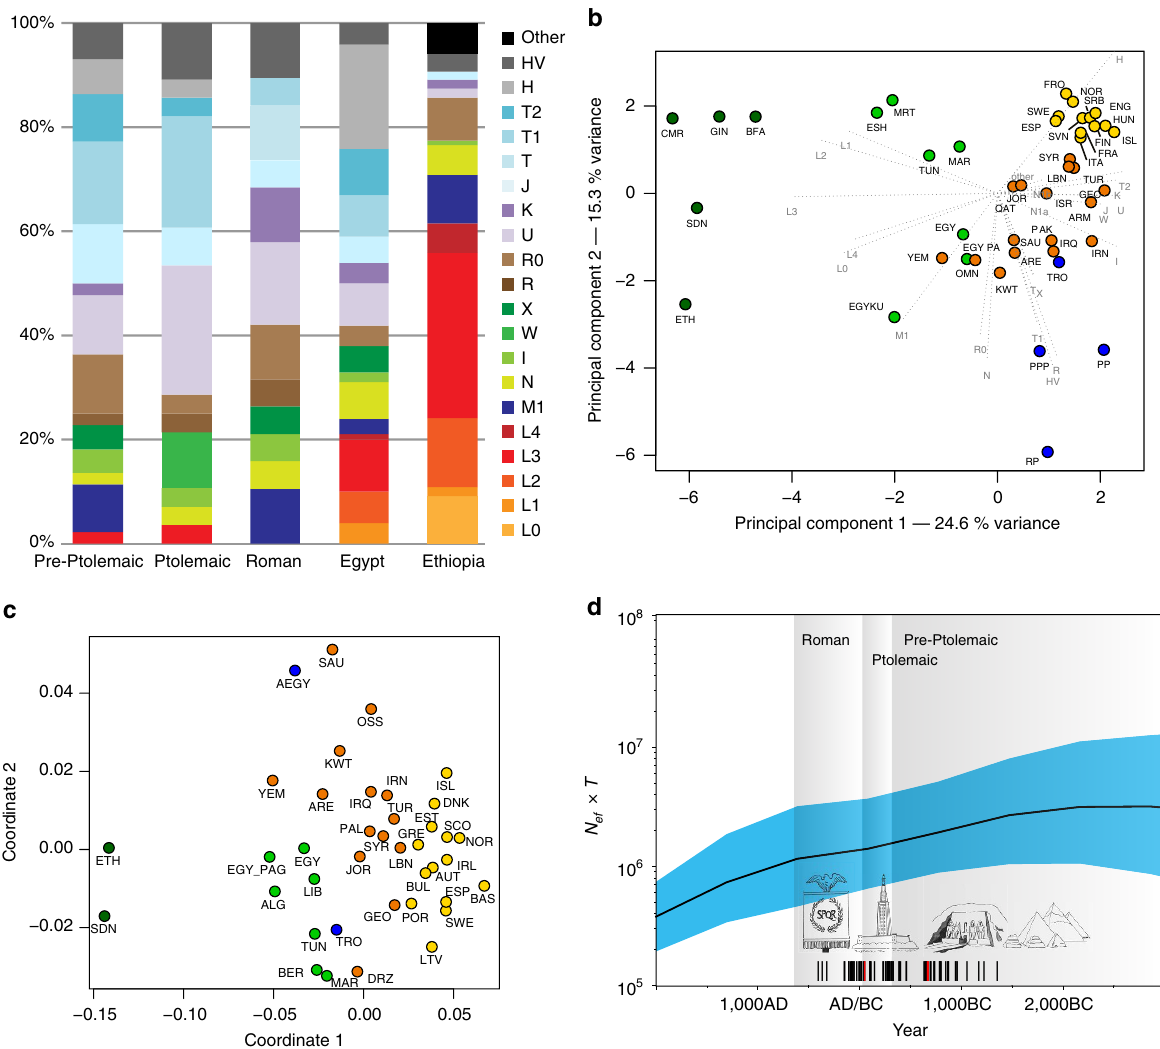
Figure 3 | Analysis of 90 ancient Egyptian mitochondrial genomes. ( a ) Mitochondrial DNA haplogroup frequencies of three ancient and two modern-day populations, ( b ) Principal Component Analysis based on haplogroup frequencies: (sub-Saharan Africa (green), North Africa (light green), Near East (orange), Europe (yellow), ancient (blue), ( c ) MDS of HVR-I sequence data: colour scheme as above; note that ancient groups were pooled, ( d ) Skygrid plot depicting effective population size estimates over the last 5,000 years in Egypt. Vertical bars indicate the ages of the analysed 90 mitochondrial genomes (three samples with genome-wide data highlighted in red). Note that the values on y axis are given in female effective population size times generation time and were rescaled by 1:14.5 for the estimation of the studied population size (assuming 29-year generation time and equal male and female effective population sizes) (images by Kerttu Majander).